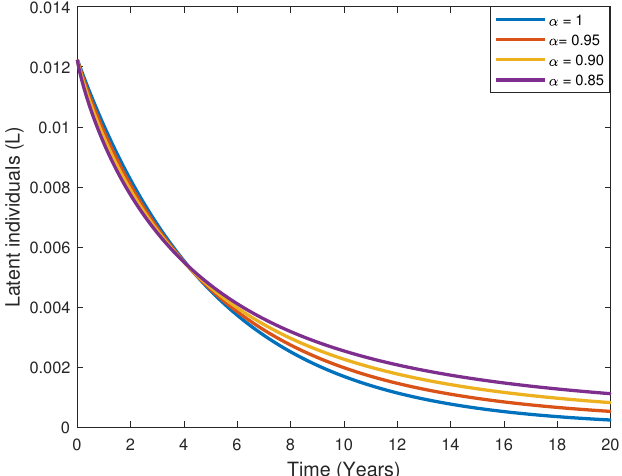
Figure 4. Behavior of L class for different α